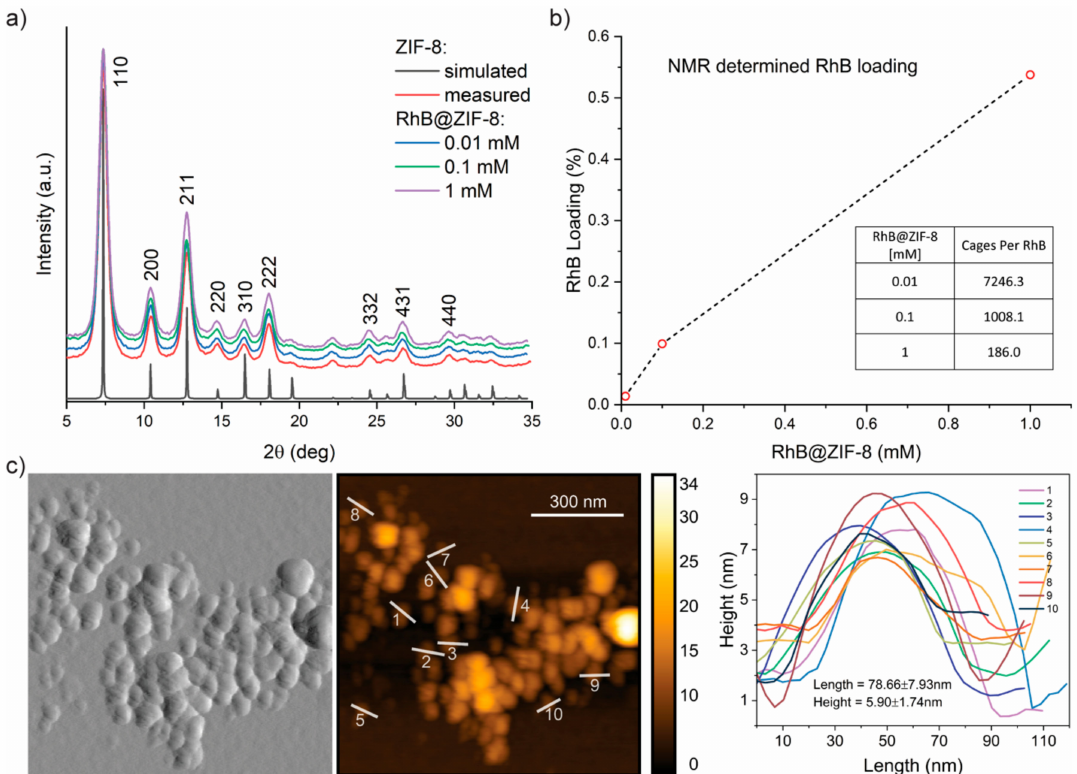
Figure 1. ( a ) PXRD patterns of the simulated and synthesized ZIF-8 and the three synthesized composite samples of RhB@ZIF-8 featuring three different RhB concentrations (mM) applied during material synthesis. The simulated pattern of ZIF-8 is calculated using the crystallographic information file (CIF) obtained from the Cambridge Structural Database (CCDC code: VELVOY). ( b ) RhB guest loadings determined by solution 1 H NMR spectroscopy. The horizontal axis represents the specific guest concentration applied at material synthesis (0.01, 0.1, 1 mM). The dotted lines show the overall trend. ( c ) AFM image of the RhB@ZIF-8 nanocrystals and the corresponding height topography extracted from the designated paths on the 3D surface reconstruction of the AFM